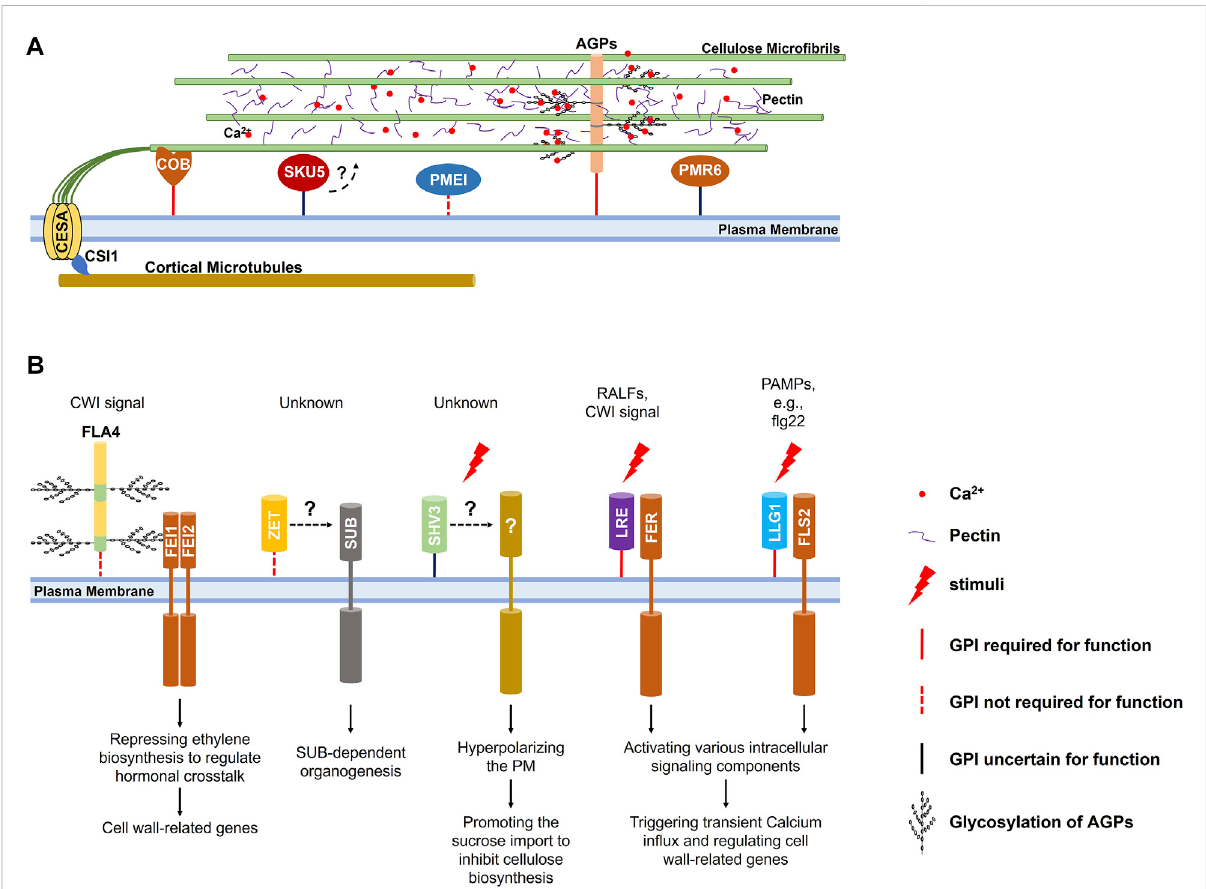
FIGURE 1 RegulationsofthecellwallbyGPI-APsin Arabidopsis . (A) ProposedmodelofGPI-APsactingtoregulatecellwallstructure.Besidesactingasthe structuralproteinthatassociateswithcellwallpolysaccharidestomediatecross-linkingofcellwallcomponentsandtheplasmamembrane-cellwall integration, classical AGPs could accumulate and release calcium ions in a pH-dependent manner to regulate pectin cross-linking; COB and its homologs participate in the alignment of cortical microtubules and cellulose micro fi brils; PMEI1 and PMR6 are involved in esteri fi cation